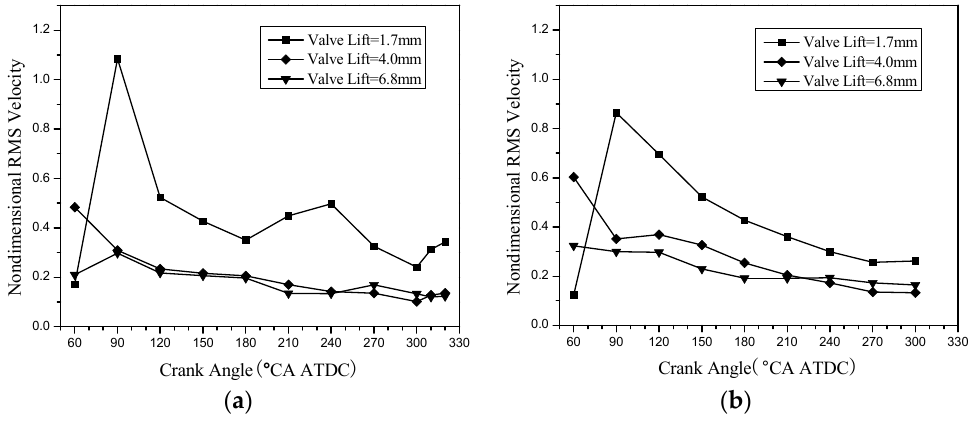
Figure 9. Variations of the total high-frequency non-dimensional root-mean-square (RMS) fluctuating velocity of swirl flow with CA for three MVLs (at ( a ) 5 mm and ( b ) 15 mm planes).